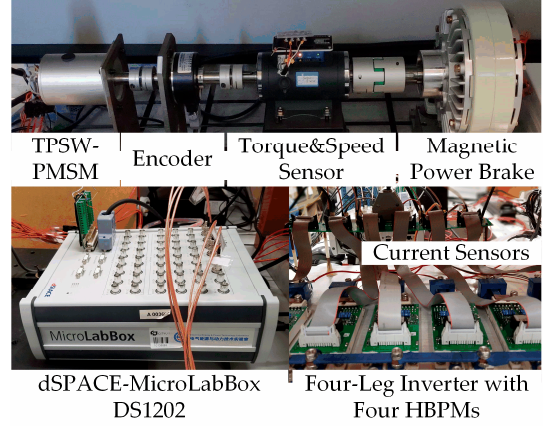
Figure 14. Testbed configuration.